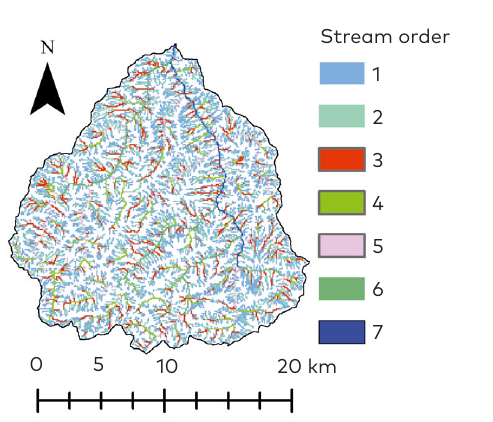
Figure 2. Stream orders of the watershed of the Çatalzeytin Bridge